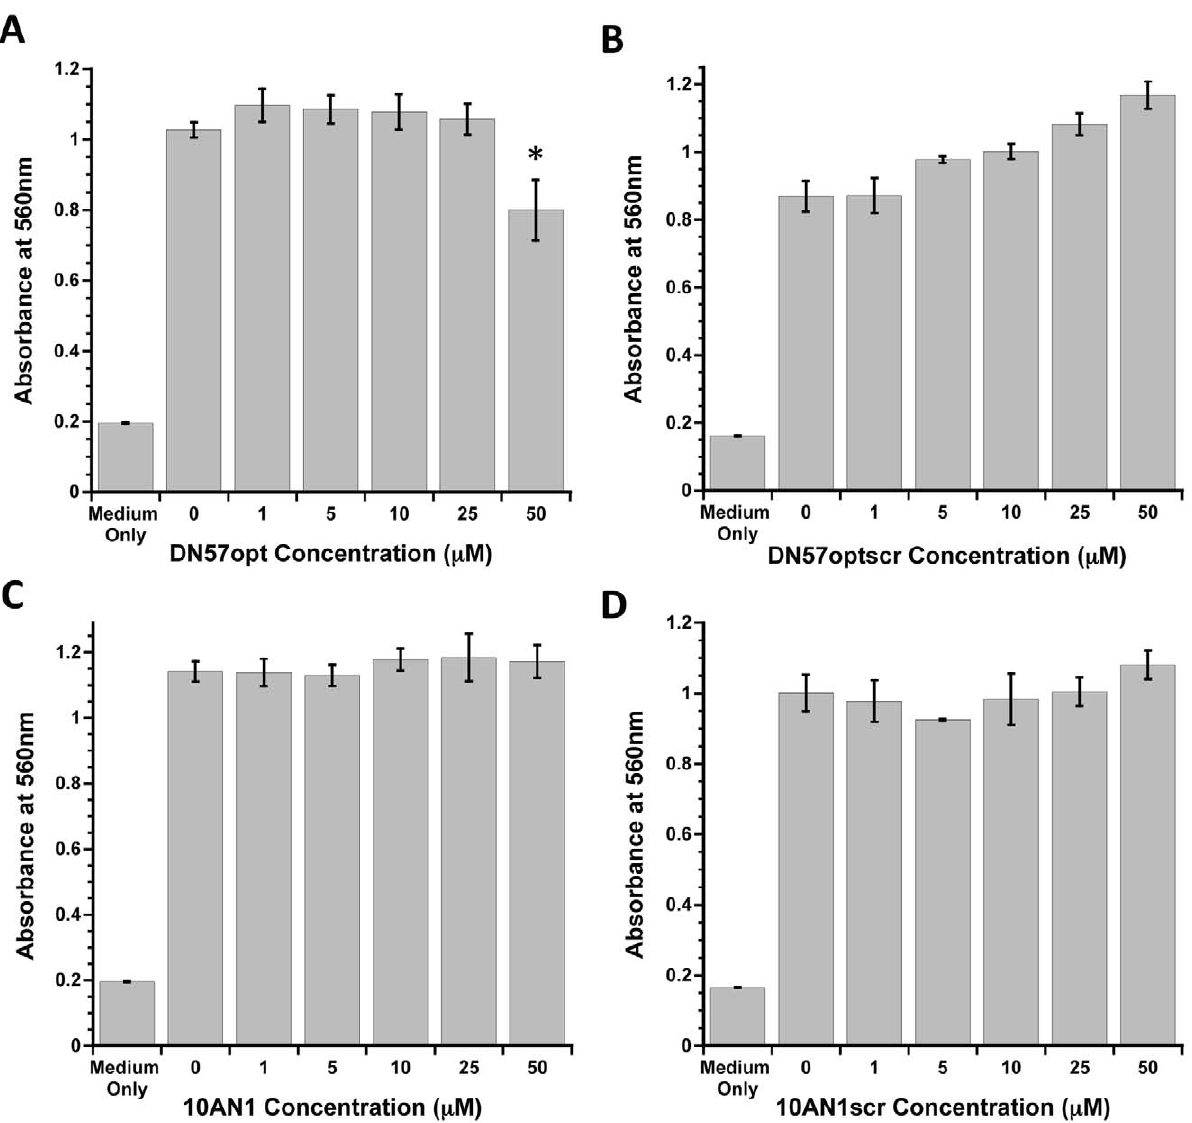
Figure 3. Inhibitory peptide toxicity invitro . Increasing concentrations of peptides were tested in an MTT mitochondrial reductase activity assay. Error bars are 6 sd. (A) DN57opt (B) Scrambled version of DN57opt (C) 1OAN1 (D) Scrambled version of 1OAN1. * denotes a statistically significant difference from the no peptide control.